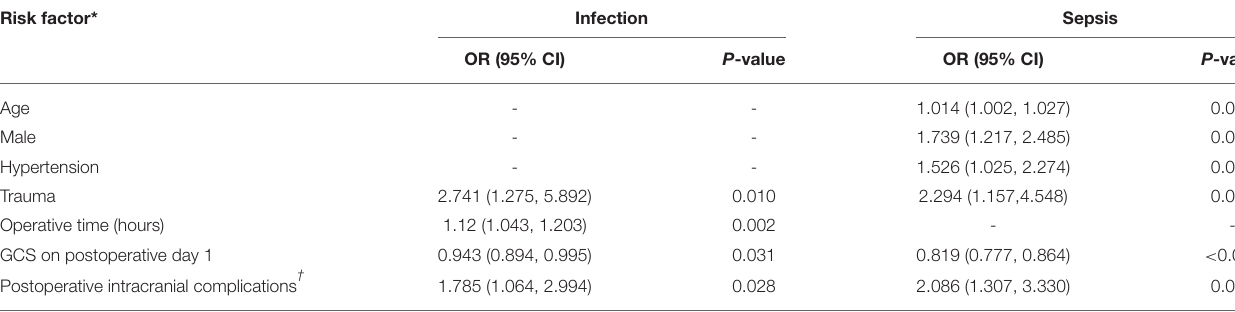
TABLE 4 | Risk factors for infection and sepsis in critically ill post-craniotomy patients.